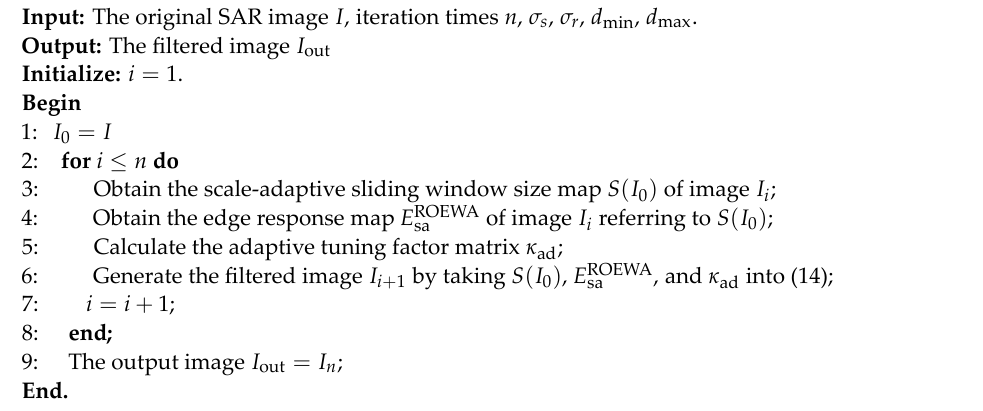
Algorithm 1 Guidance‑aided triple‑adaptive Frost